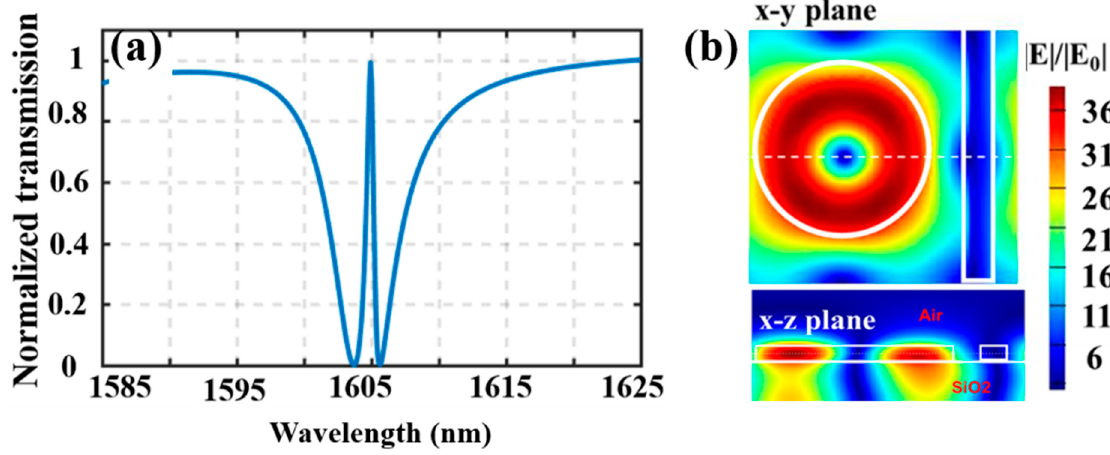
Figure 3. ( a ) Transmission spectrum corresponds the structure parameters of R = 350 nm, L = 1100 nm, t = 340 nm, w = 100 nm, g 1 = 155 nm, g 2 = 145 nm, and ∆ g = 10 nm. ( b ) Electric field distribution of the x-y plane cross-section (cut through the middle of the TFLN), where its amplitude is divided with respect to the incident electric field strength E 0 . The bottom is the electric field distribution in the x-z plane cross-section (cut through the middle of the LN disk, as shown as the dashed line through the disk), where its amplitude is divided with respect to the incident electric field strength E 0 .